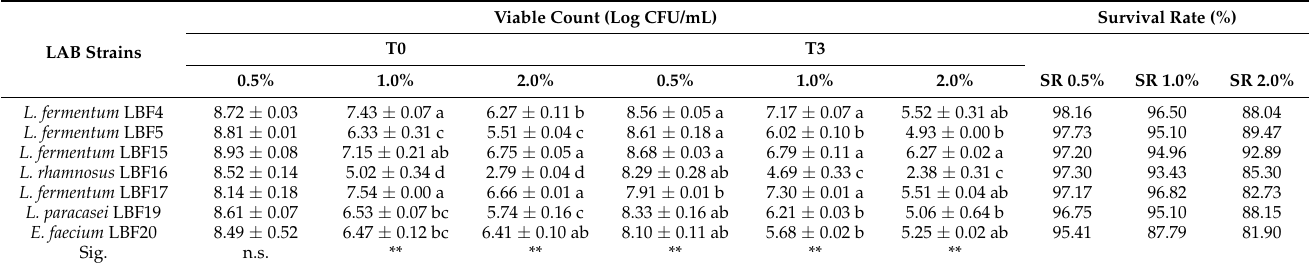
Table 2. Tolerance to bile salt presence at different concentrations.